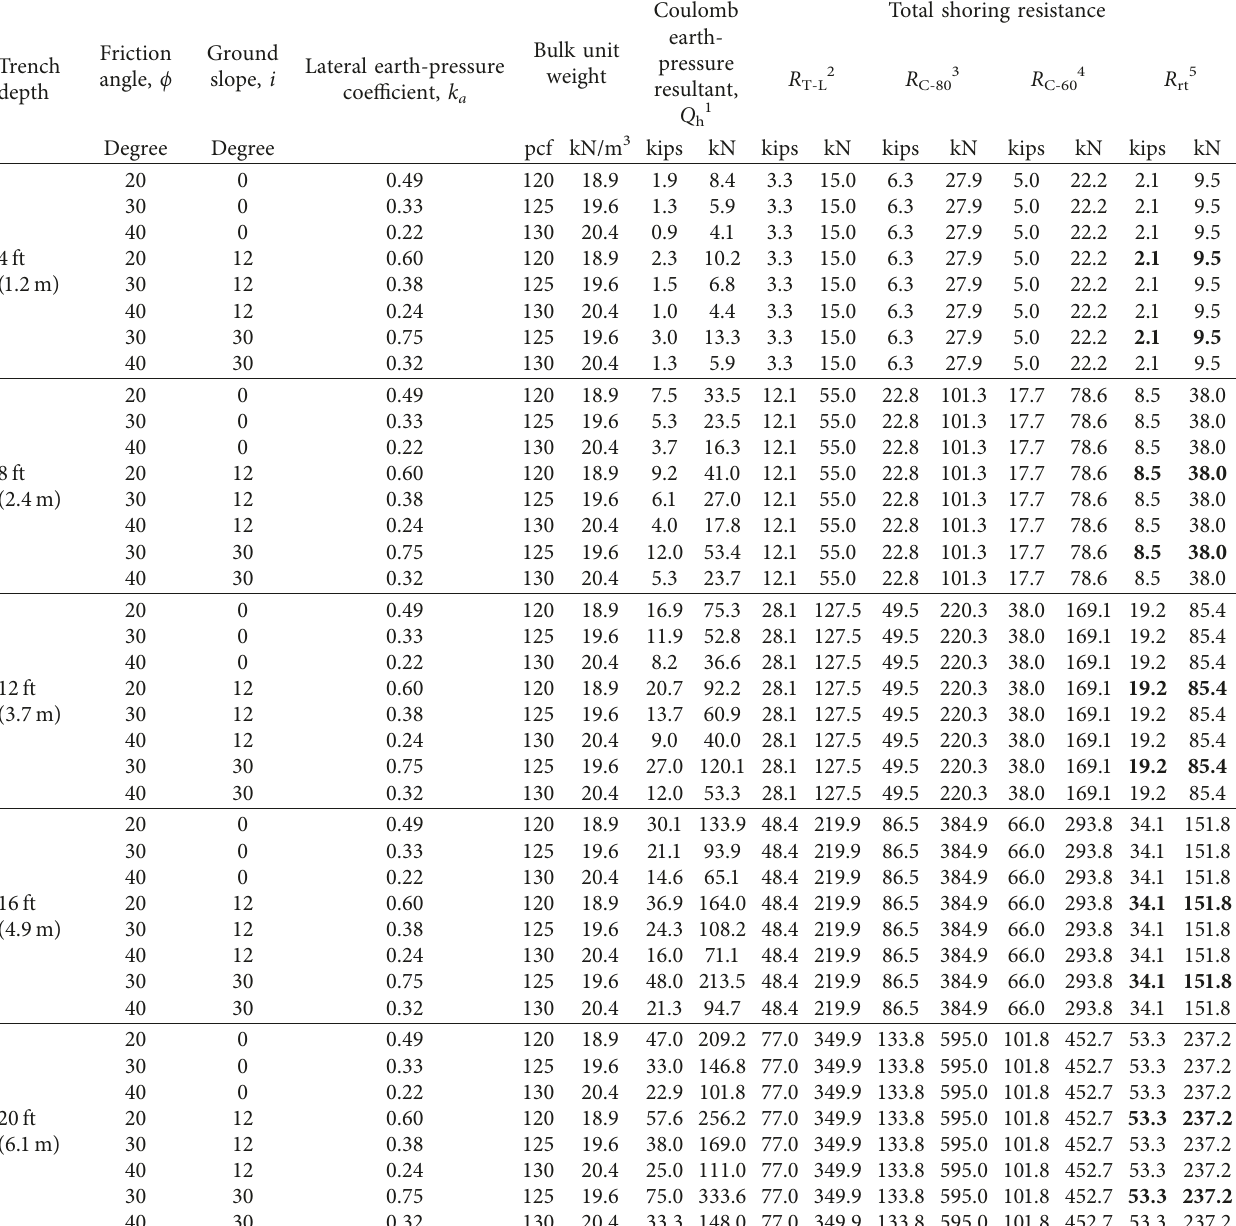
Table 2: Coulomb earth-pressures versus the total shoring resistance of the T-L method and the C-80 method. Bold values denote a failure condition where the expected resistance is less than the calculated earth-pressure force.